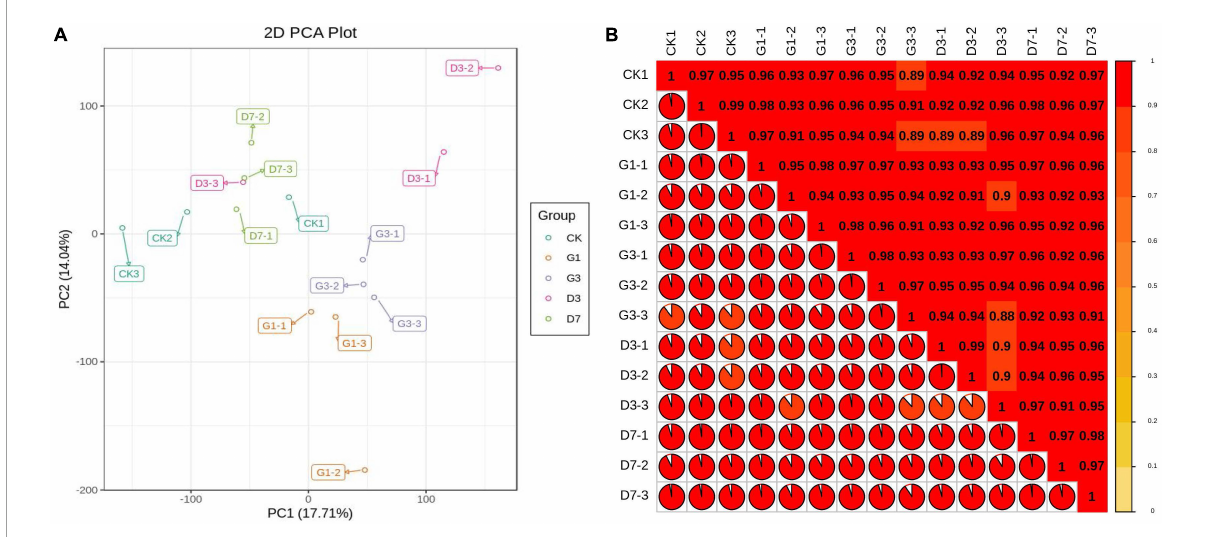
FIGURE7 Identification and characterization of differentially accumulated metabolites (DAMs) in the peel of different treatments. (A) DEG statistics among the four comparison groups in the different treatments. (B) Venn diagram showing the shared and specific DEGs among the four comparison groups of the different treatments. KEGG enrichment analysis of the DEGs in the (C) CK_vs_G3, (D) CK_vs_D7, (E) G3_vs_D3, and (F) G3_vs_D7 groups.